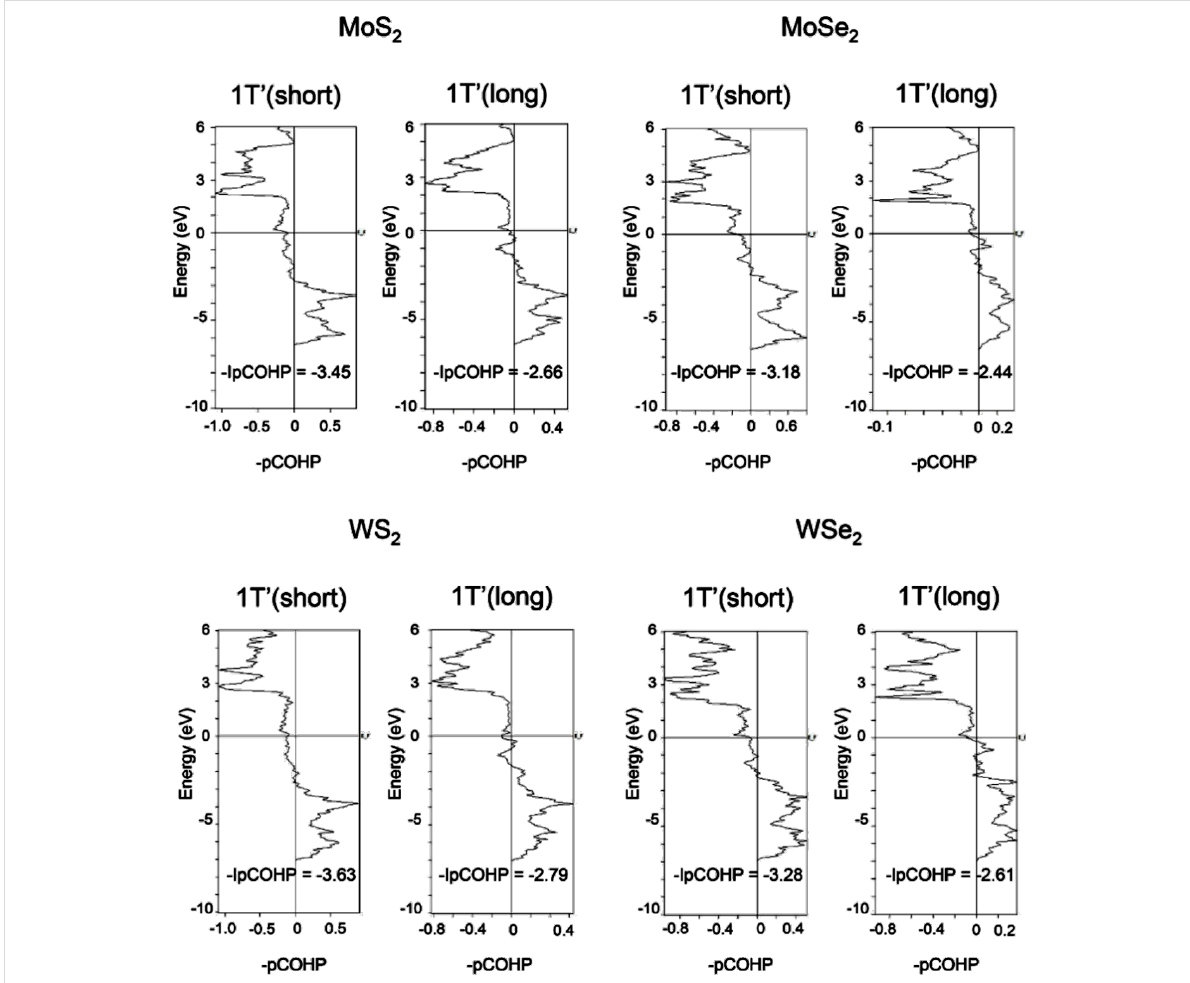
Figure 3: Calculated -pCOHP of long and short TM-X bonds in 1T ′ MoS 2 , MoSe 2 , WS 2 and WSe 2 crystals with the corresponding -IpCOHP values. The long and short TM-X bonds are indicated in Figure 1.